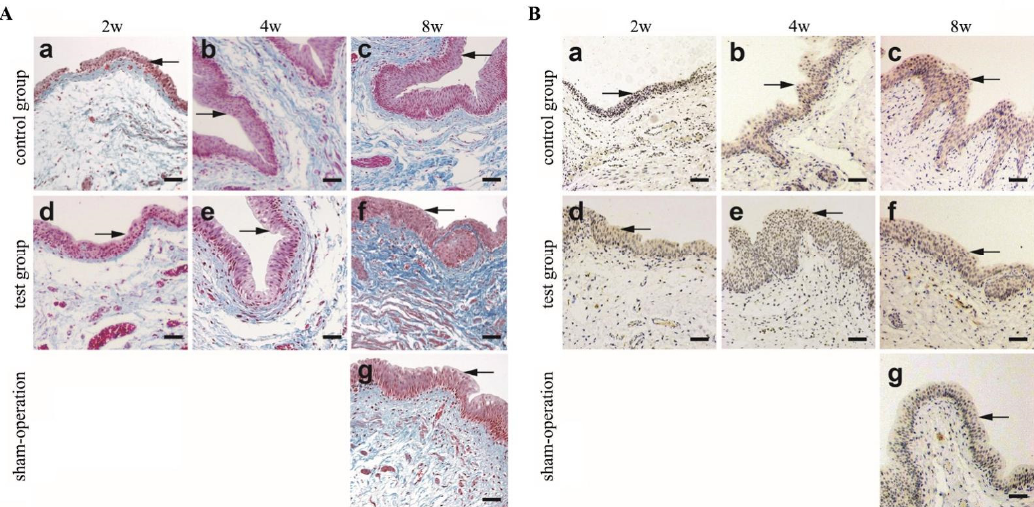
Figure 3. Masson’s trichrome and immunohistochemical staining with CK 13 to identify urothelial cells. ( A ). The results showed that Masson's trichrome stained epithelial cells gradually increased with time (2w to 8w). At 2nd week, the control group (a) and the test group (d) revealed that urothelium layers in marginal zone. At 8th week, a large number of urothelial cells are arranged orderly to form urothelium layers in control group (c) and test group (f). The epithelial cell density of control group, test group and sham-operation group (g) was similar by Masson‘s trichrome staining ( left ). ( B ). The results showed that CK13 stained epithelial cells gradually increased with time (2w to 8w). At 2nd, 4th, and 8th week after surgery, the urothelial cells growth in the control group (a–c) and test group (d–f). At 8th week, the urothelium layers in control group (c) and in test group (f) was thicker than that in the sham-operation group (g) by Immunohistochemical staining with CK 13 ( right ). Urothelial cells are indicated by arrows. (Scale bar = 50 µ m).